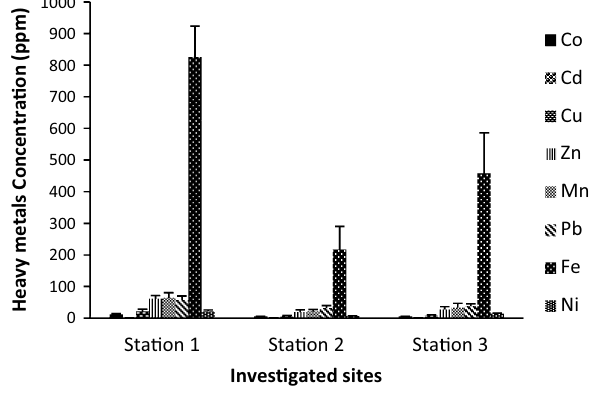
Fig. 5 Spatial distribution of heavy metals concentrations across investigated